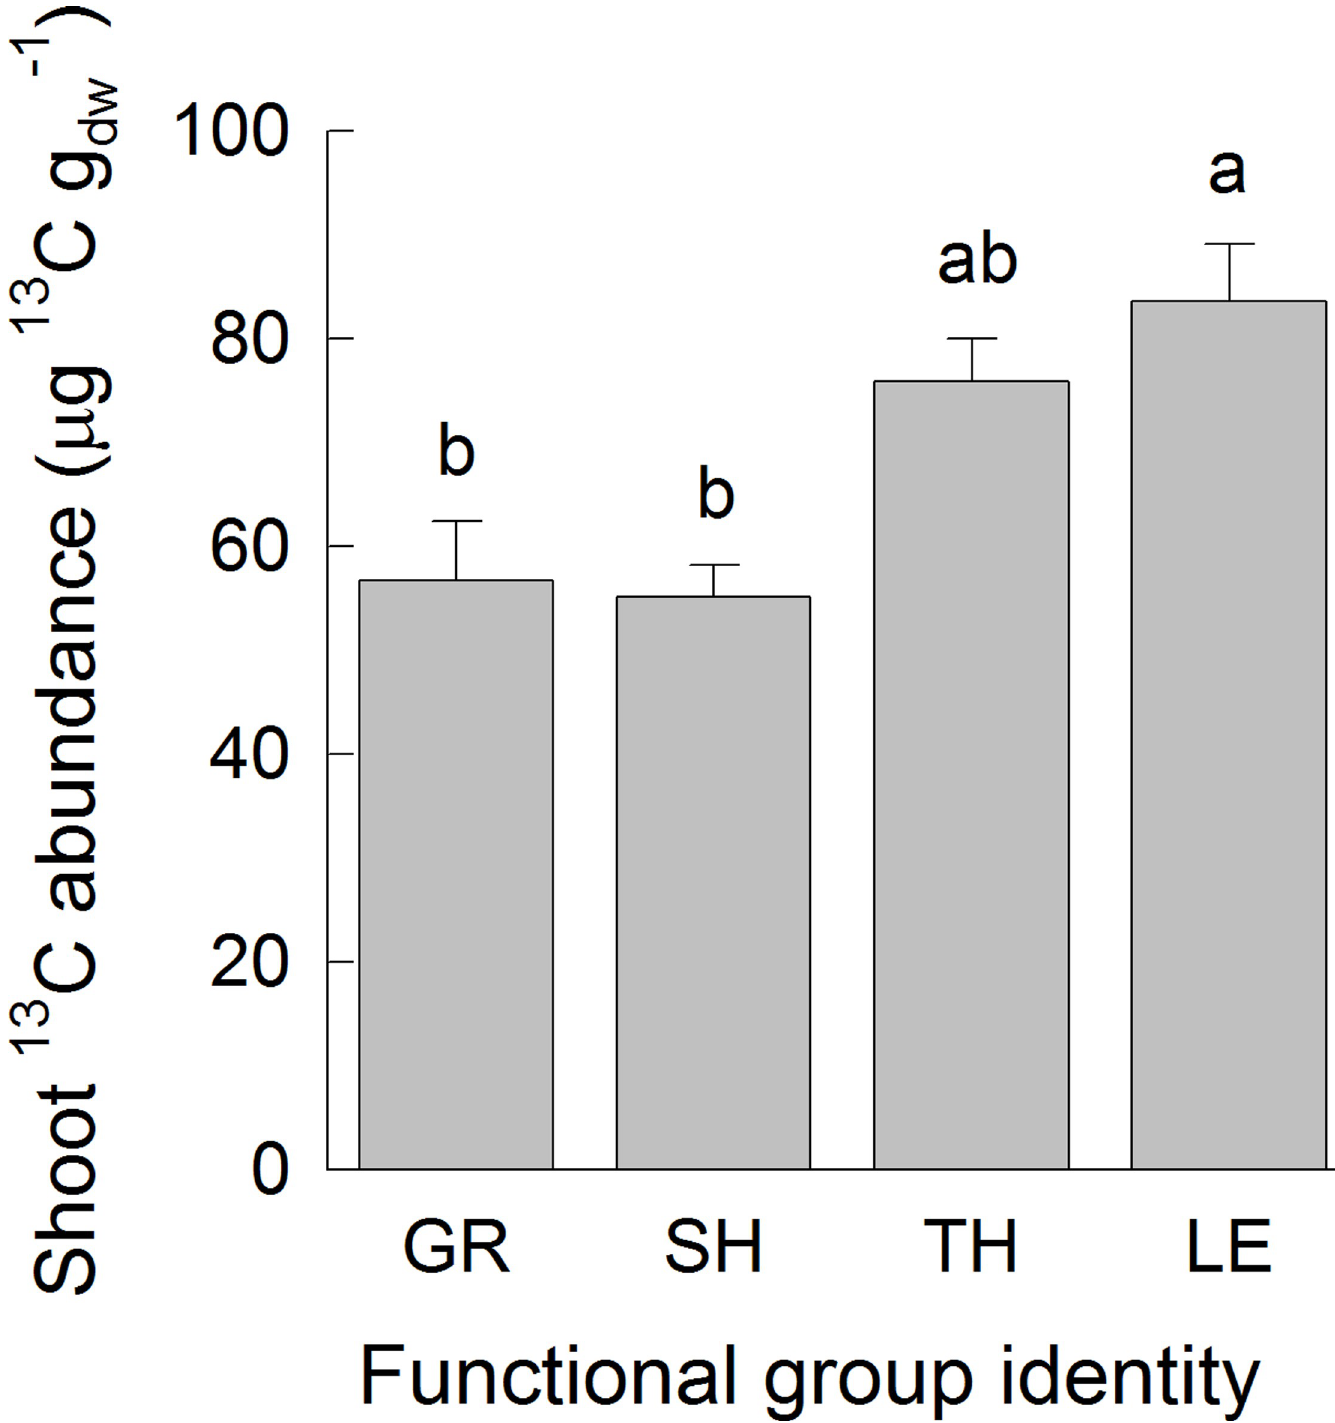
Fig 3. Species-level 13 C abundances in shoot biomass. Shown are means (+1 SE) per functional group. Results of Tukey‘s test (P < 0.05) applied to test for significant differences among functional groups are indicated with letters. Abbreviations are: GR = grasses, SH = small herbs, TH = tall herbs, LE = legumes.